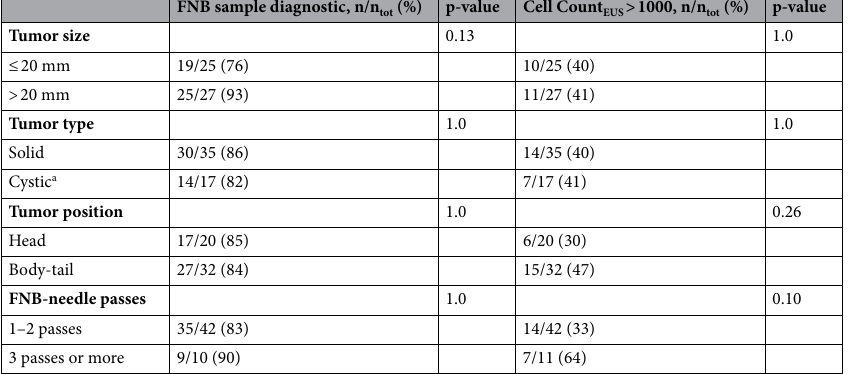
Table 3. Factors with a potential impact on the biopsy yield and quality of EUS-FNB samples. a Tumor with a partially or entirely cystic appearance at endosonography.